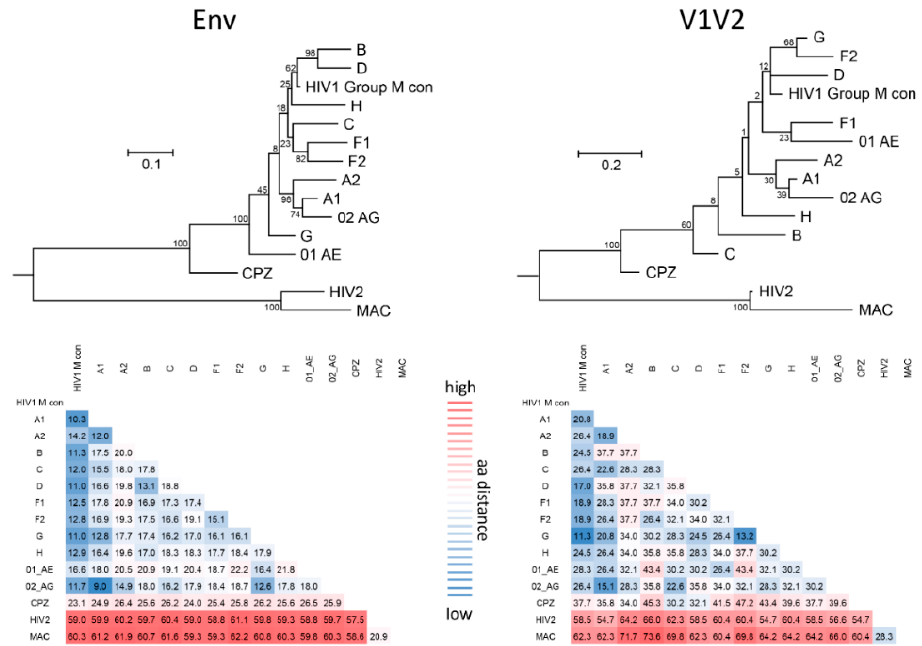
Figure 1. Phylogenetic diversity and aa distance analysis of diverse HIV-1 clades, HIV-2 and SIV. ( Top ): maximum likelihood phylogenetic trees of Env ( left ) and V1V2 ( right ) aa consensus sequences of major HIV-1 clades, HIV-2, and SIV from chimpanzees (cpz) and macaques (mac). An additional consensus sequence summarizing all HIV-1 group M consensus sequences was used (HIV-1 group M con). The consensus sequences were downloaded from the Los Alamos National Library (LANL) Database, if available, or generated from the alignments of functional aa sequences that were used for Figure 2 (Consensus Maker, LANL Database). Maximum likelihood phylogenetic trees were constructed using MEGA v5.2, and the Poisson substitution model with 200 Bootstrap replicates; Bootstrap values are indicated. ( Bottom ): pairwise aa distance analysis between Env ( left ) and V1V2 ( right ) consensus sequences. The heatmap displays aa distances in percent, color-coded according to the scheme in the middle. The distances were calculated in MEGA v5.2 using the Neighbor-joining p-distance